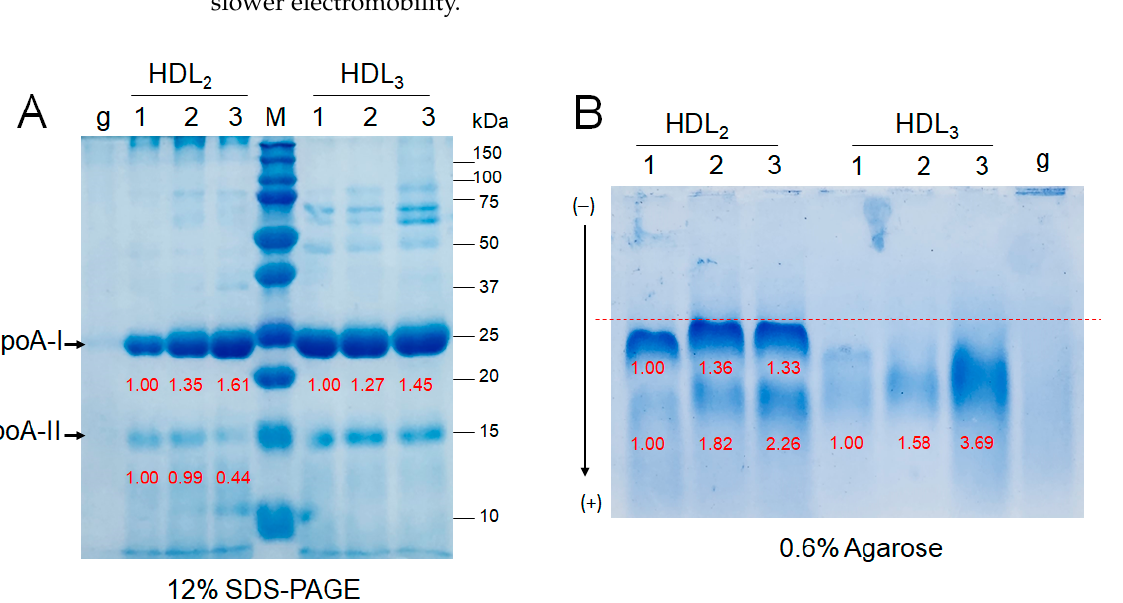
Figure 4. Transmission electron microscopy (TEM) images and area analysis of HDL 3 from each group ( A ) and comparison of particle sizes ( B ). gHDL 3 , glycated HDL 3 .